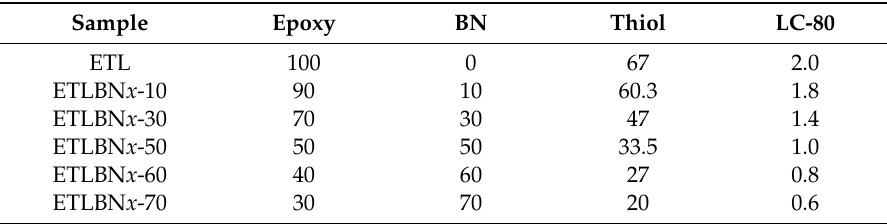
Table 1. Composition by weight of epoxy-thiol samples filled with BN particles with size x = 2, 30, 180 µ